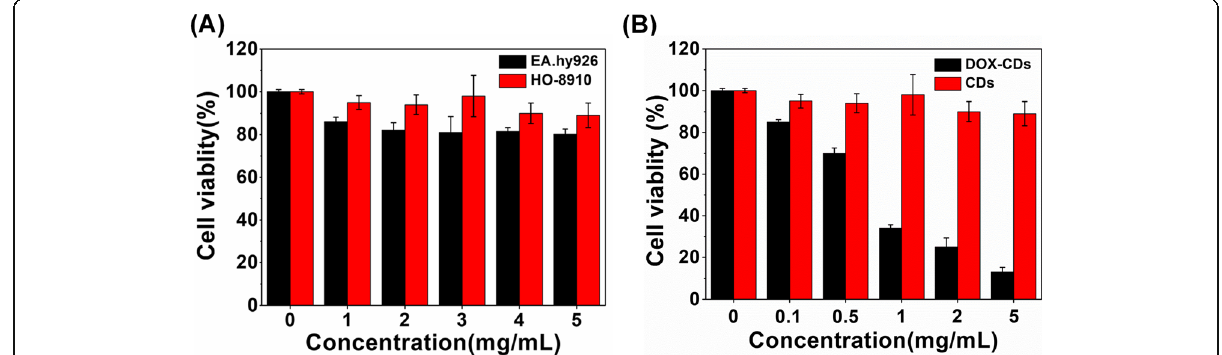
Fig. 3 In vitro cell cytotoxicity. a Biocompatibility of CDs against HO-8910 and EA.hy926 cells. b Cell cytotoxicity of DOX-CDs and CDs against HO-8910 tumor cells. Values are expressed as mean ± SD, ( n =